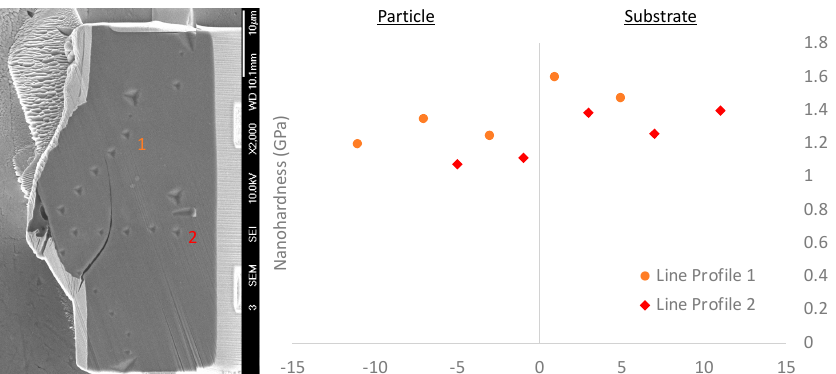
Figure 53. ( Left ) SEM micrograph of cross-sectioned Al 6061 single particle deposit depicting the locations targeted during nanoindentation. The residual indentation marks found from ( Left ) correspond with the plotted data ( Right ).